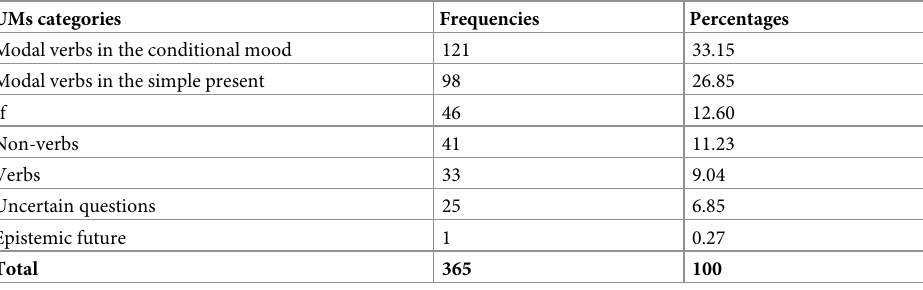
Table 13. Frequencies and percentages of UMs in Discover